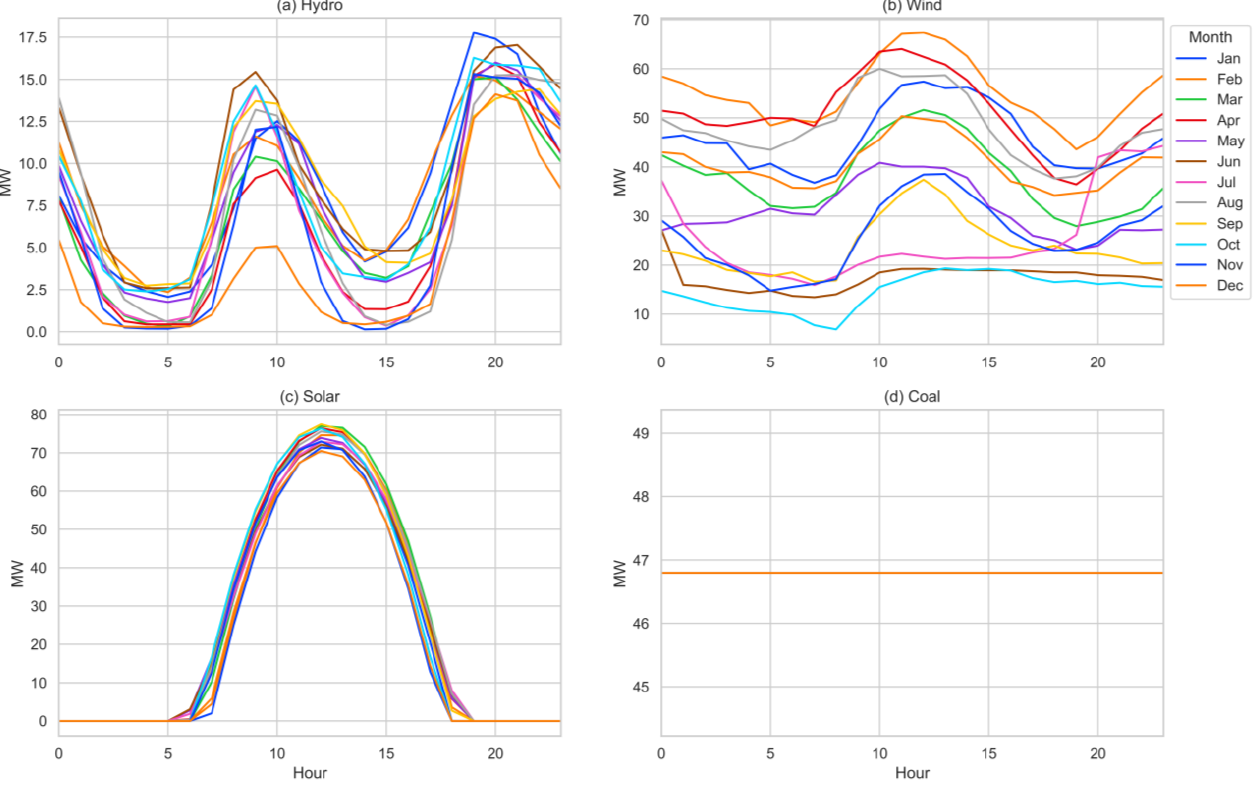
Figure 6. Generation curves by source: ( a ) hydro; ( b ) wind; ( c ) solar photovoltaic; ( d ) coal power plant.